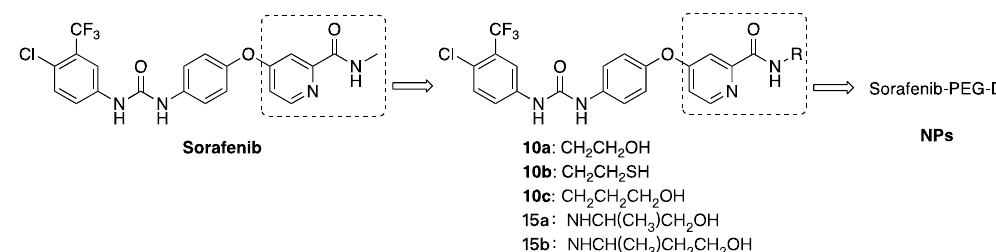
Figure 2. Design of sorafenib derivatives and nanoparticles (NPs).